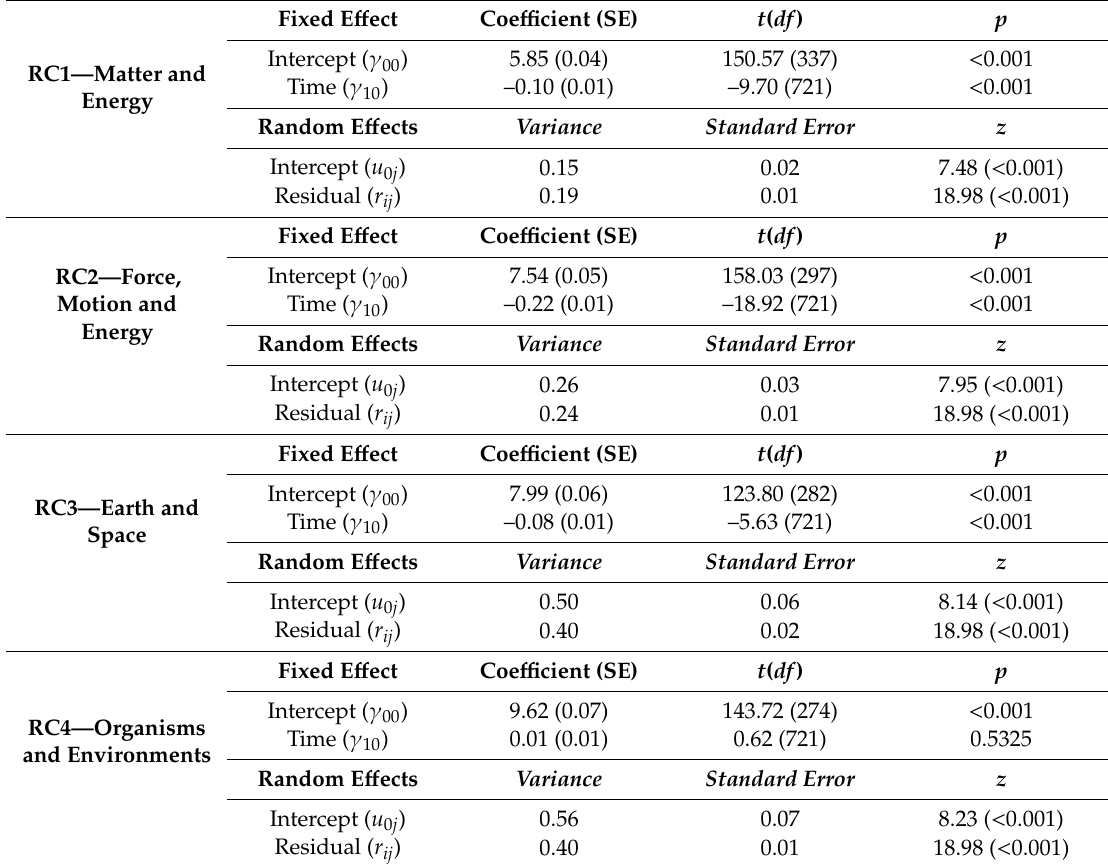
Table 4. Parameter estimates of fixed and random e ff ects of Model 2 by reporting